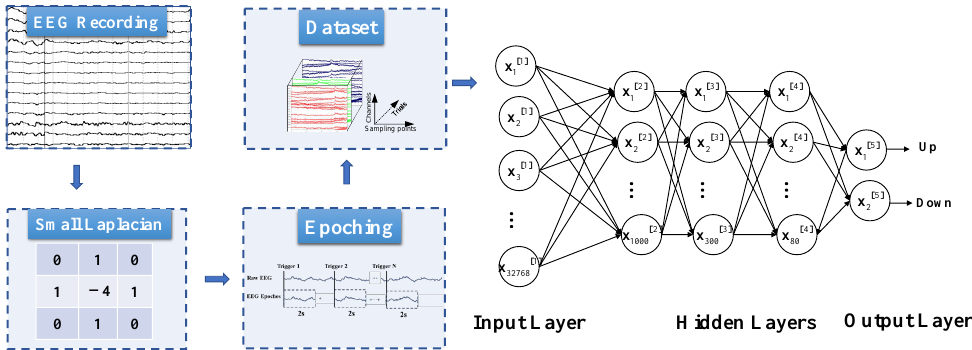
Figure 3. DNN-based framework for the decoding. U and D refer to lower-limb extension ( up ) and flexion ( down ),